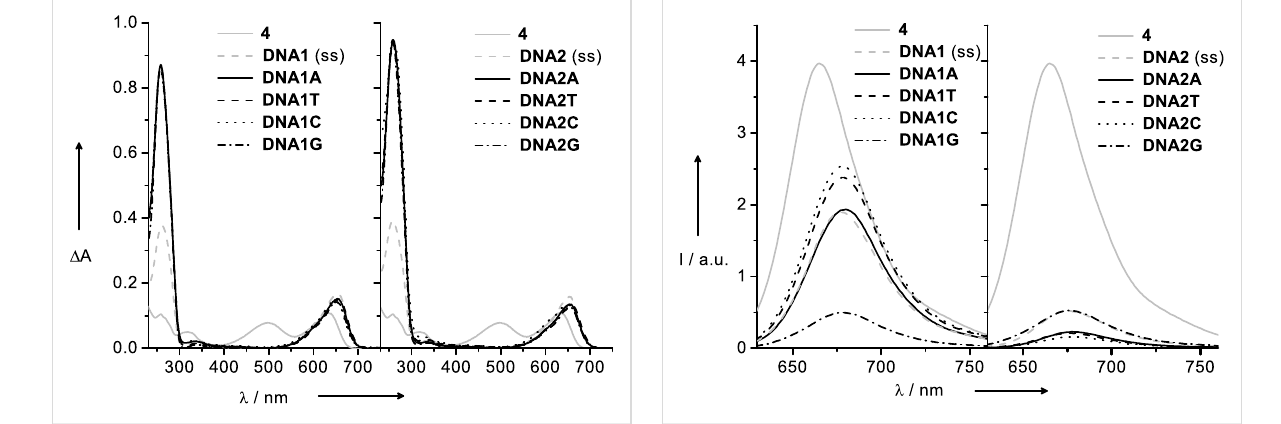
Figure 1: UV–vis absorption spectra of single-stranded DNA1 and DNA2 , and the corresponding duplexes DNA1Y and DNA2Y (2.5 μM) in sodium phosphate buffer (10 mM) of pH 7.0, NaCl (250 mM), λ exc = 610 nm.